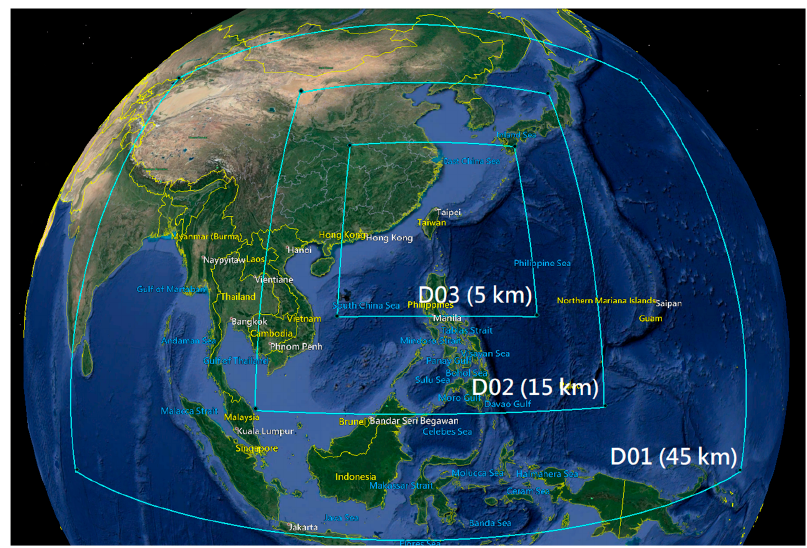
Figure 1. Extents of the Weather Research and Forecasting (WRF) model with grid spacings of approximately 45 km for Domain 1 (D01), approximately 15 km for Domain 2 (D02) and approximately 5 km for Domain 3 (D03).